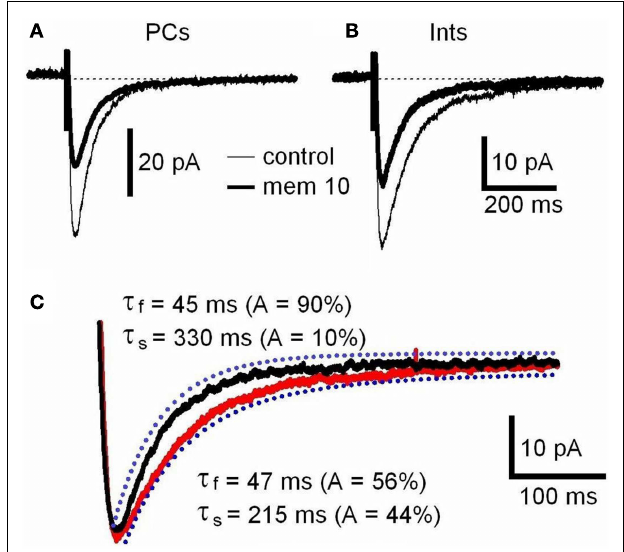
FIGURE 4 | NMDAR deactivation kinetics in PCs and Ints. (A,B) Examples of traces of NMDAR currents measured before (control, thin line) and after memantine (10 µ M; thick line) application are shown for PCs and Ints, respectively. NMDAR currents were recorded from individual PCs and Ints voltage-clamped at V m =− 70mV. Each trace is an average of 30 acquisitions. (C) Decay time-course of NMDAR currents recorded in PCs (black line) and Ints (red line).The traces are normalized to the amplitude. Blue dotted line: fitting of the deactivation kinetics of NMDAR currents. Note that the decay of the NMDAR currents in Ints (red line) was slower than that of PCs (black line).